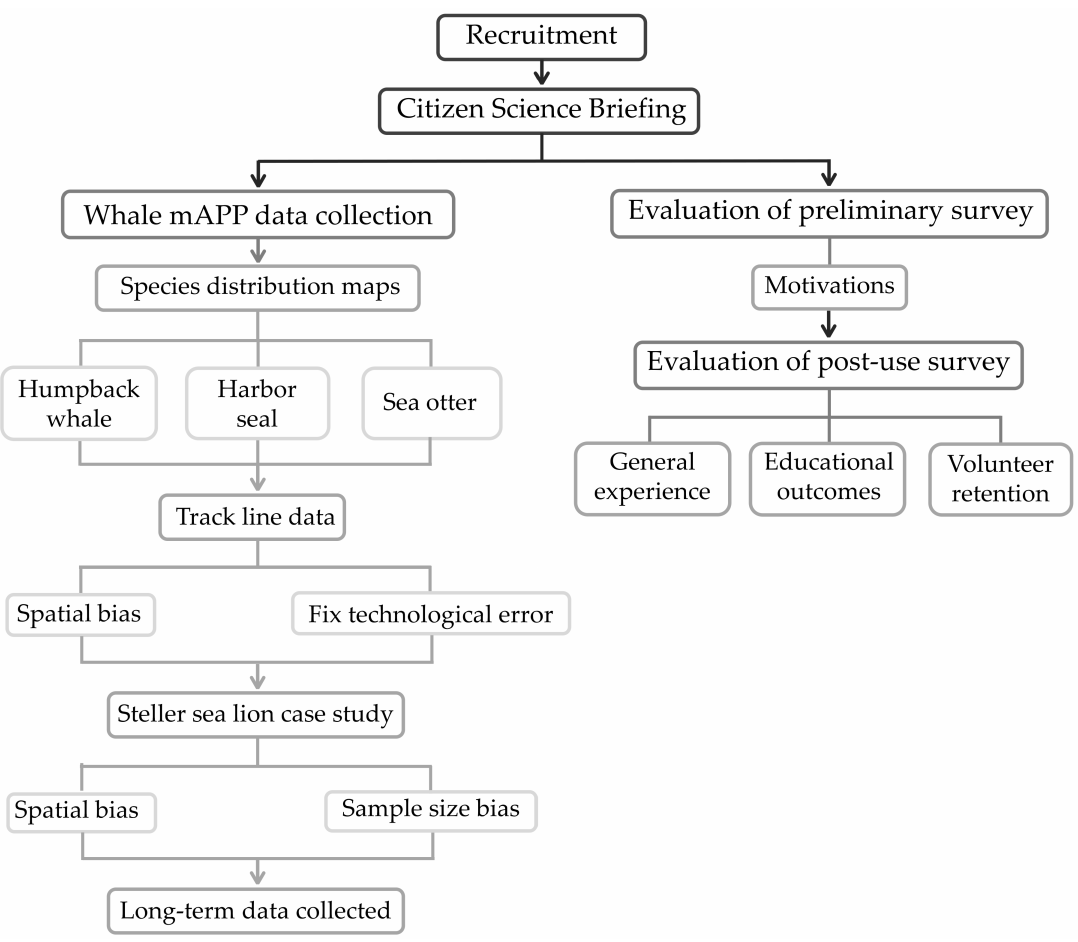
Figure 2. Flowchart of methods with the left hand column showing how the Whale mAPP data were used and the right hand column describing how the questionnaire survey data were